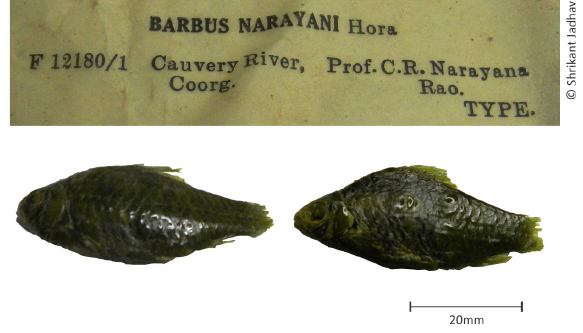
Image 6. Syntypes of Pethia narayani ZSI Kolkata F